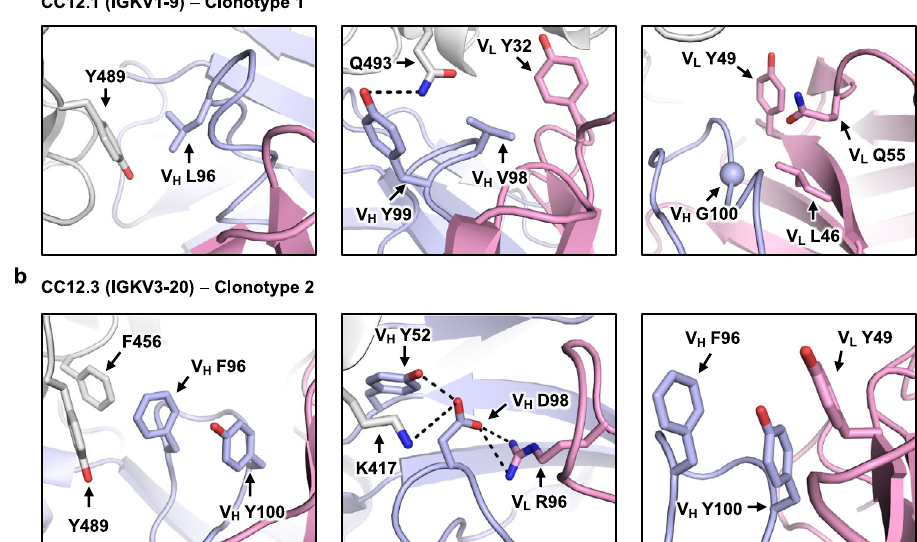
Fig. 2 Structural analysis of sequence signatures in CDR H3 of clonotypes 1 and 2. a Interaction of L96, V98, and G100 (Kabat numbering) in CDR H3 of CC12.1 (PDB 6XC2) with the IGKV1-9 light chain of the antibody, and SARS-CoV-2 RBD. b Interaction of F96, D98 and Y100 (Kabat numbering) in CDR H3 of CC12.3 (PDB 6XC4) with the IGKV3-20 light chain of the antibody, and SARS-CoV-2 RBD. Gray: RBD; light blue: heavy chain; pink: light chain. V H and V L indicate residues belong to the heavy and light chain of the antibody,